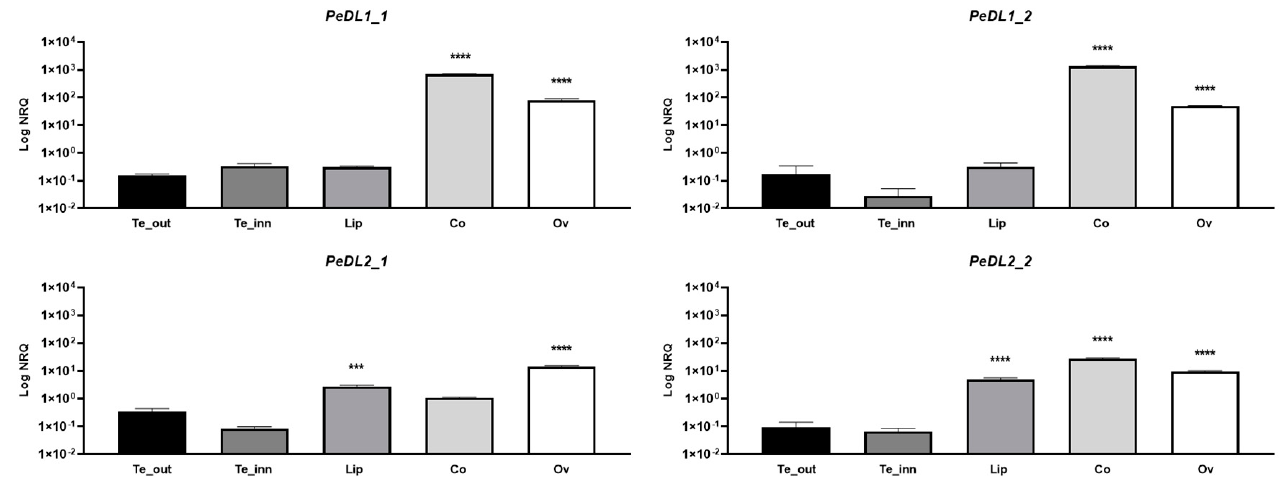
Figure 3. Relative expression of the different isoforms of the PeDL1 and PeDL2 genes in the floral tissues of the wild-type Phalaenopsis hyb. “Athens” at the B2 developmental stage (bud size 1–1.5 cm). The expression is reported as logarithm of the normalized relative quantity (Log NRQ). The bars represent the SEM of the biological and technical replicates. The asterisks indicate the statistically significant difference of the expression compared to outer tepals. p -Values *** <0.001, **** <0.0001. Te_out, outer tepals; Te_inn, lateral inner tepals; Co, column; Ov, ovary.